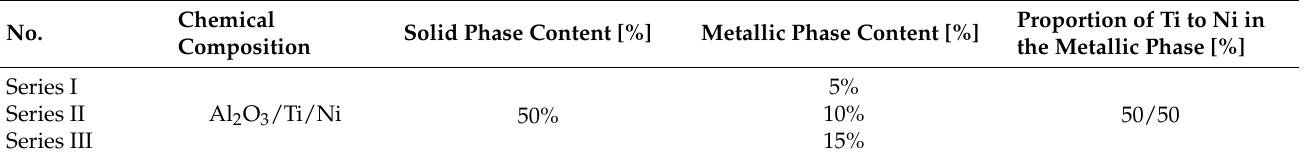
Table 2. Characteristics of the sample series included in the